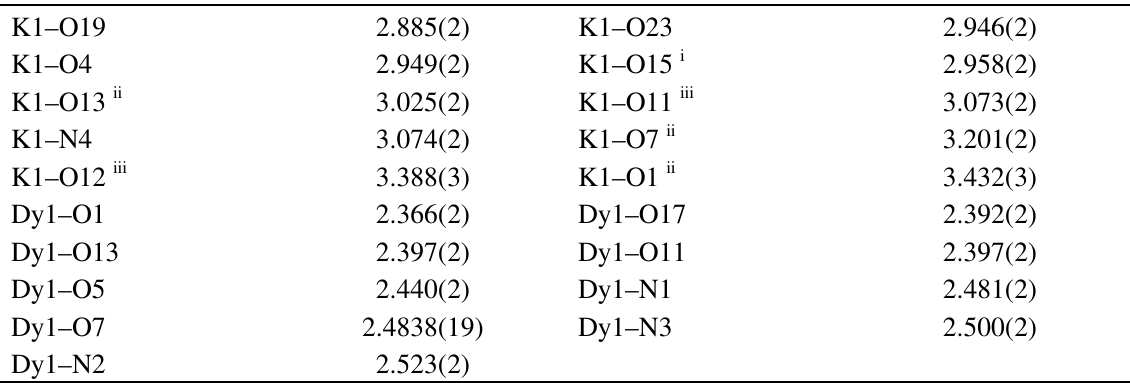
Table 1. Selected bond-distances (Å) in 1.